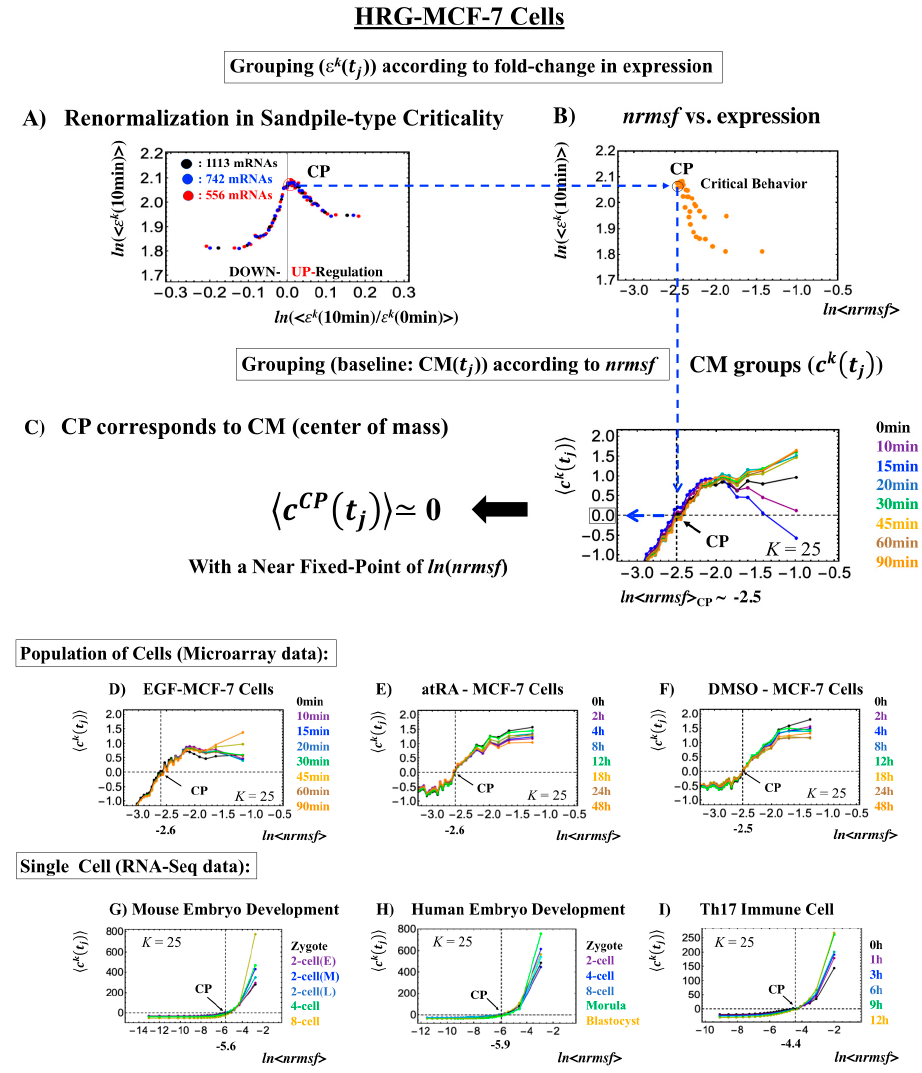
Figure 2. Fixed CP corresponding to the center of mass (CM) of genome expression: ( A ) Different numbers of groups ( ε k ( t ) , k = 1,2, ... , K : non-CM grouping; black: K = 20; blue: 30; red: 40 groups; groups contained 1113, 742, and 556 mRNA species, respectively) in HRG-stimulated MCF-7 cells followed the same sandpile-type critical behavior. This reveals the existence of scaling behavior (i.e., renormalization). ( B ) ln < nrmsf > value of the CP: logarithm plot of the average normalized root mean square fluctuation ( nrmsf ) value of a group, ln < nrmsf > vs. average expression value, ε k ( 10min ) shows that ln < nrmsf > CP ~ − 2.5 in sandpile-type criticality, where ε k (10 min) represents the expression value of the k th group (ordered from high to low nrmsf values) at t = 10 min and < ... > represents the ensemble average of group expression. Grouping for (A) and (B) is ordered according to the fold-change in expression at 0–10 min. ( C ) Grouping (CM grouping: Section 4.2.2) of whole-genome expression (baseline: CM( t j )) according to nrmsf reveals that this can be considered a fixed point and corresponds to the CM of whole-genome expression. This is true for both the population ( C – F ) and single-cell levels ( G – I ). K represents the number of groups with n number of elements (( C , D ): n = 891 mRNAs; ( E , F ): n = 505 mRNAs; ( G ): n = 685 RNAs; ( H ): n = 666 RNAs; ( I ): K = 25, n = 525 RNAs; coloring: Section